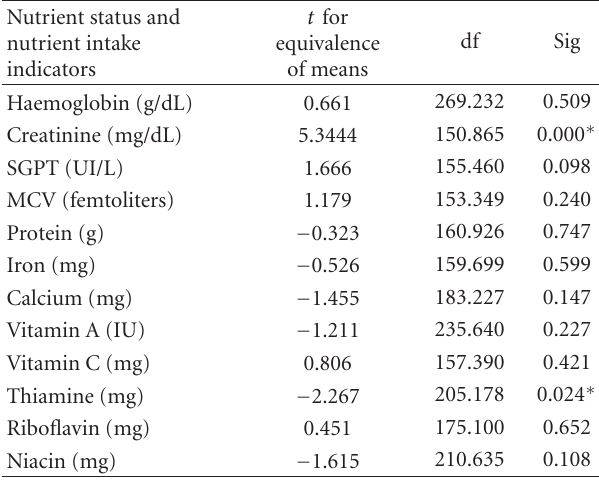
Table 6: The di ff erence in mean values of nutrient intake and nutrient status between males and females ( n =